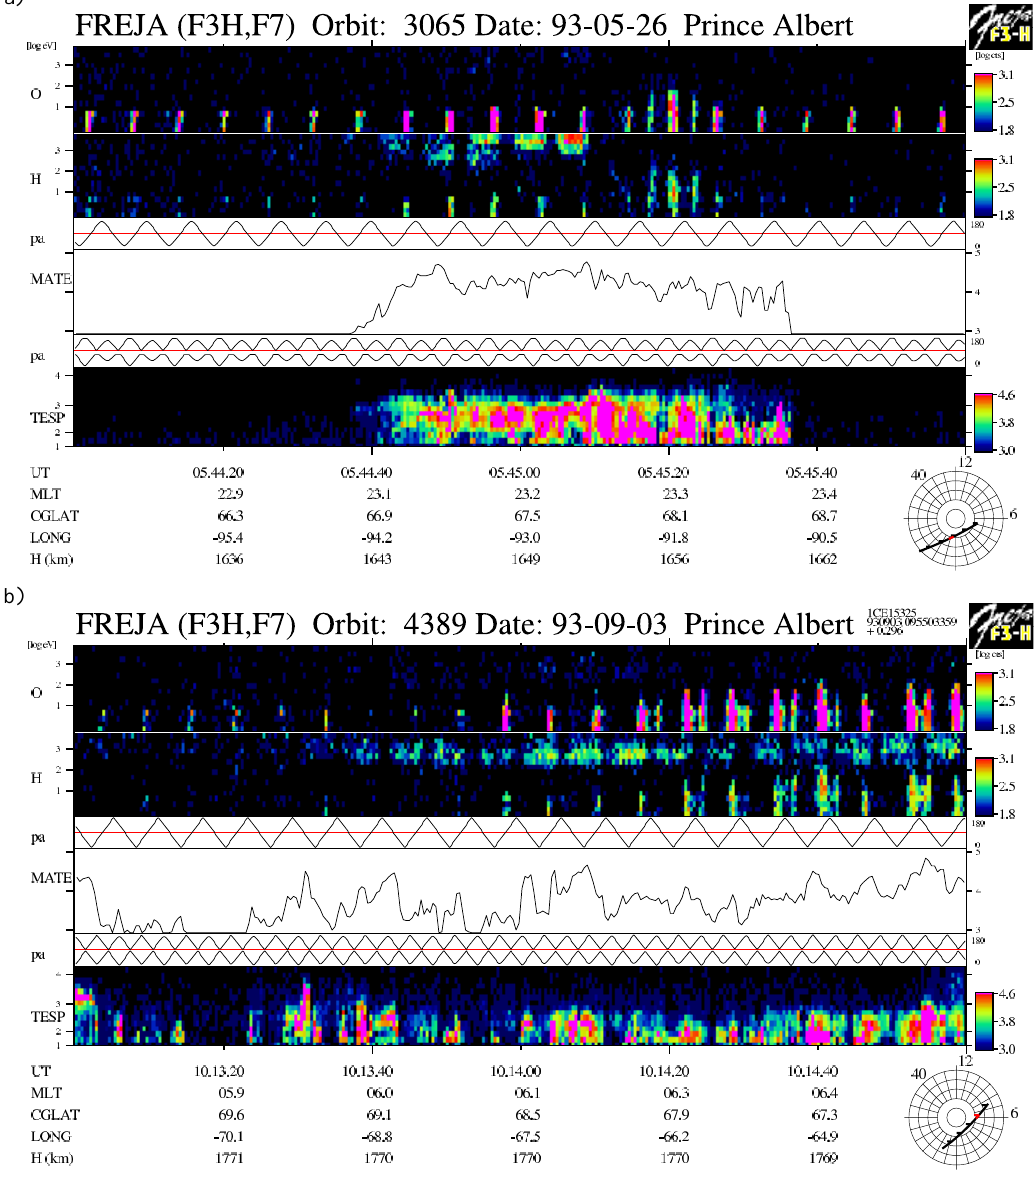
Fig.26. Examples of relations of precipitated ions to ion conics. In (a) ions are precipitated next to conics but not in them. In (b) ion precipitation occurs both before the conics and together with the conics. The precipitated ion fluxes are lower in the conics region and their energy spectra appear to be wider